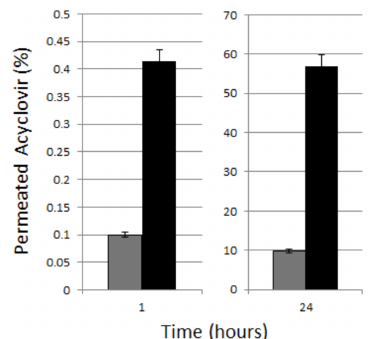
Figure 3. Comparison of Acyclovir permeation through porcine skin from the chitosan NS gel and commercial